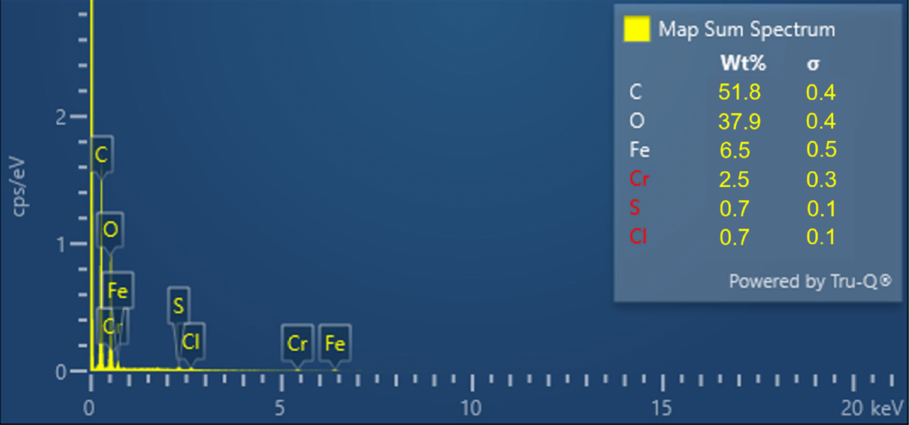
Figure 14. Identification peaks of the elemental composition of GO-based